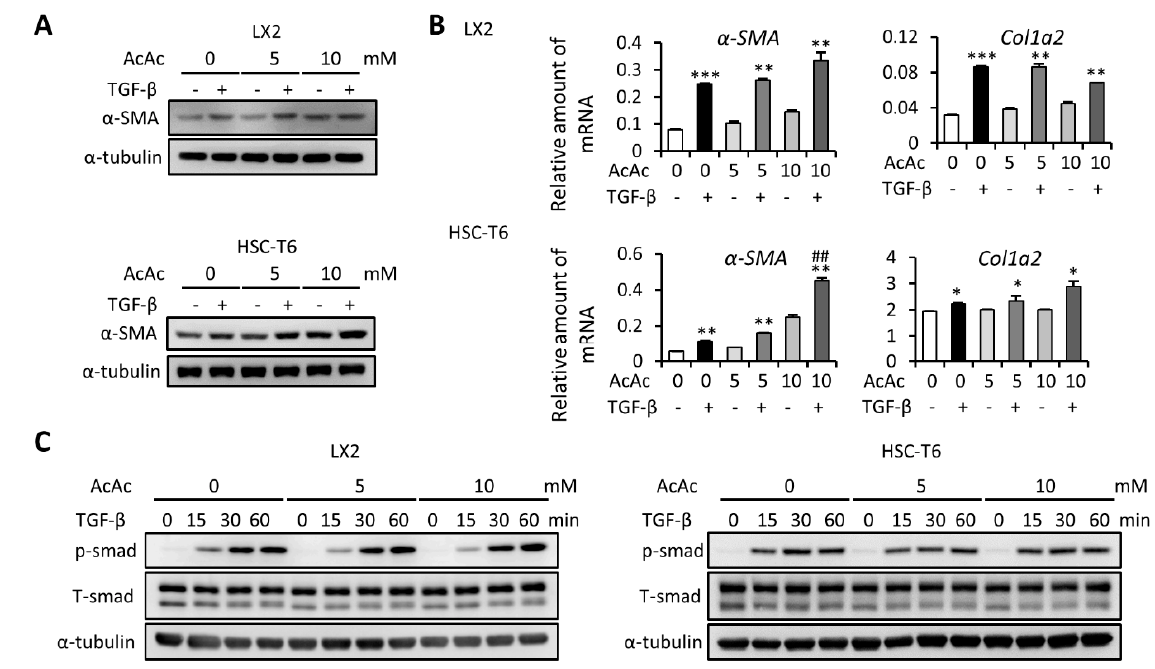
Figure 4. Effects of acetoacetate (AcAc) on TGF- β 1-induced LX2 and HSC-T6 cell activation. ( A , B ) LX2 and HSC-T6 cells were treated with 10 ng/mL TGF- β and 0, 5, or 10 mM of AcAc for 24 h. Western blot and qPCR were used to evaluate the protein and mRNA expression of α -SMA and Col1a2. ( C ) LX2 and HSC-T6 cells were treated with 0, 5, or 10 mM of AcAc for 24 h and then subjected to 10 ng/mL TGF- β for the indicated time periods, and the lysates were analyzed by Western blot and quantification to detect SMAD protein phosphorylation. *, p < 0.05; **, p < 0.01; ***, p < 0.001 vs. relative control. ##, p < 0.01 vs. black bar. Data are shown as means ± SD.